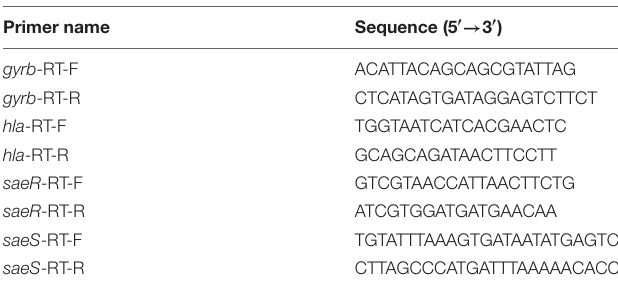
TABLE 1 | Primers used for qRT-PCR.